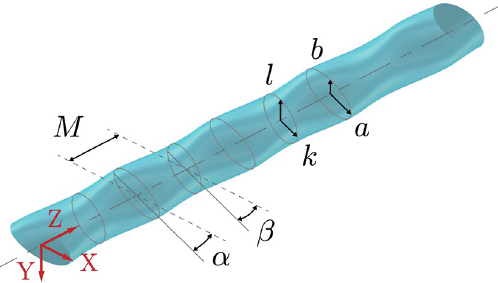
Fig 2. Geometry of baseline model. Geometric parameters of the baseline model as originally defined by Hanke et al. [2] create two coordinating sets of spanwise undulations along the z -axis. The seal whisker model is created from two different sized ellipses a distance M apart, major radii a and k , minor radii b and l , inclined at incident angles α and β with respect to the x -axis. Nominal values for harbor seal whiskers are M = 0.91 mm, a = 0.595 mm, b = 0.240 mm, k = 0.475 mm, l = 0.290 mm, α = 15.27 degrees, and β = 17.60 degrees [2].